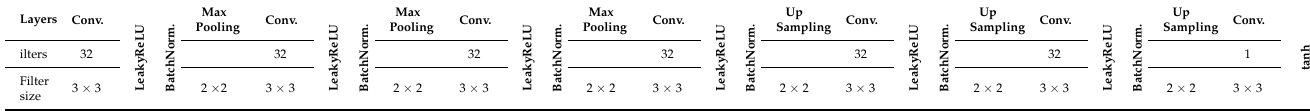
Table 1. List of hyperparameters for the proposed deep networks.